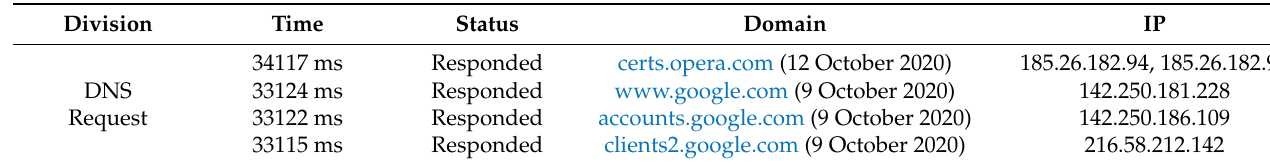
Table 8. DNS Requests packet analysis results.